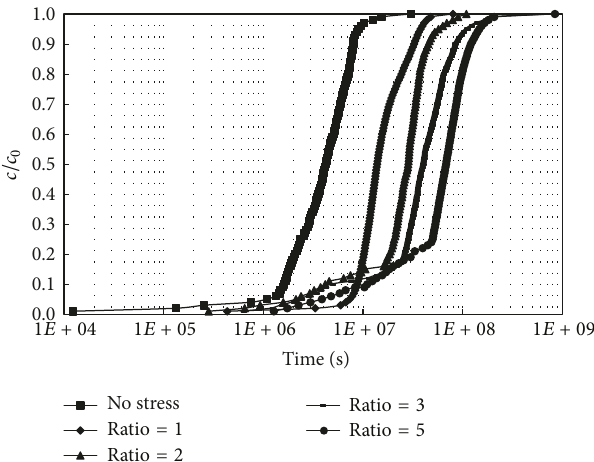
Figure 15: Breakthrough curve with different stress ratios with matrix